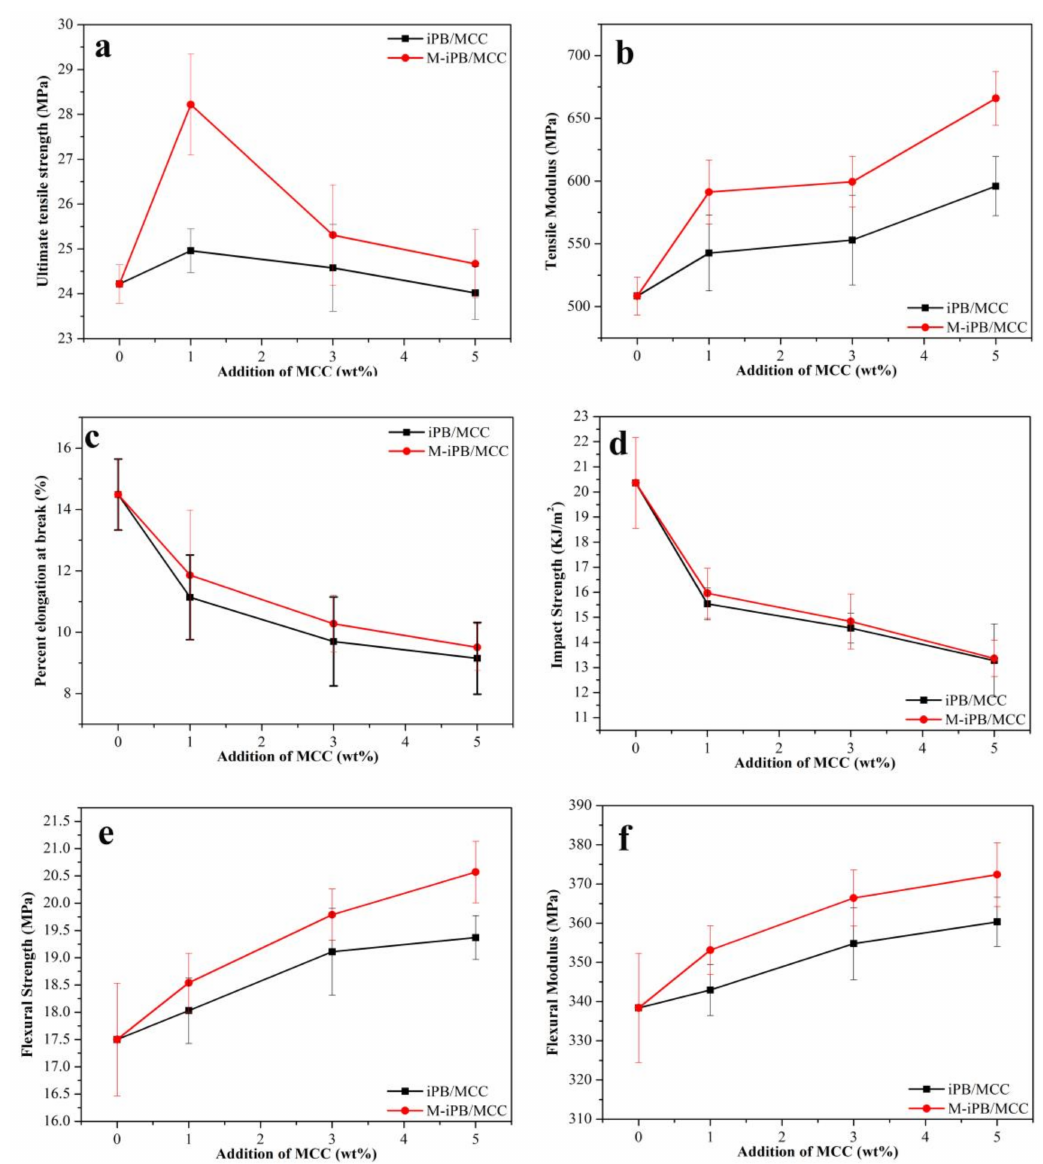
Figure 3. Mechanical properties of iPB/MCC composites ( a ) ultimate tensile strength; ( b ) tensile modulus; ( c ) percent elongation at break; ( d ) impact strength; ( e ) flexural strength; ( f ) flexural